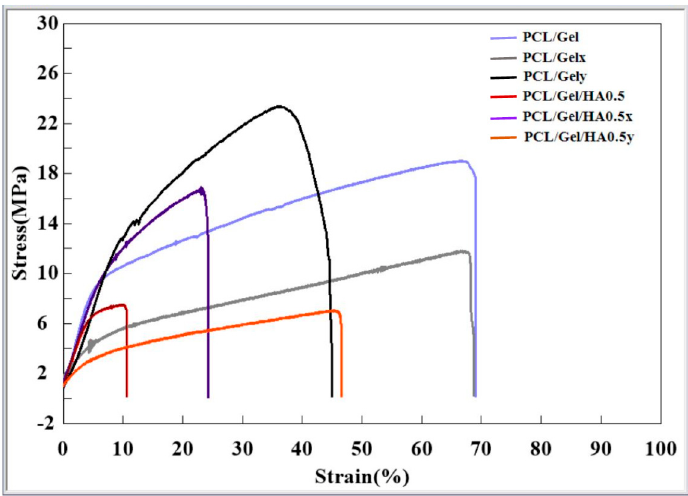
Figure 4. Stress–strain curves of PCL/Gel, PCL/Gelxy, PCL/Gel/HA, and PCL/Gel/HAxy scaffolds.